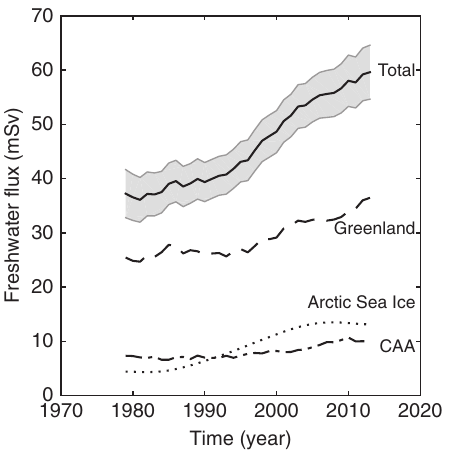
Figure 5 | Thickness of LSW and total freshwater flux and salt flux of Irminger Water. Grey solid line indicates the thickness of LSW, black solid line indicates total freshwater flux and dotted line indicates salt flux of Irminger Water. Thickness and salt flux are smoothed with a 3-year running mean. Thickness is obtained from the objective analysis of EN4.0.2 data set from the UK Met Office Hadley Center 52 . Thickness is averaged over 50 (cid:2) N–65 (cid:2) N and 38 (cid:2) W–65 (cid:2) W. Expression of salt flux in terms of freshwater flux is shown in Supplementary Fig.